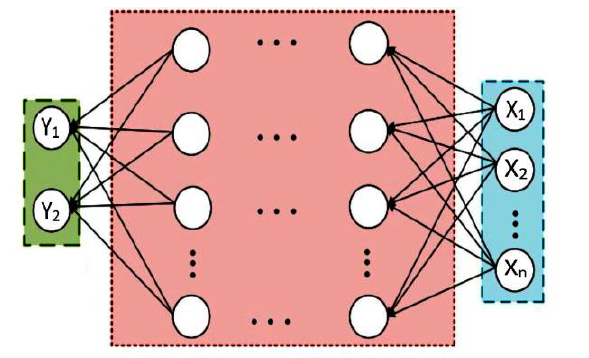
Figure 4. Deep Neural Network